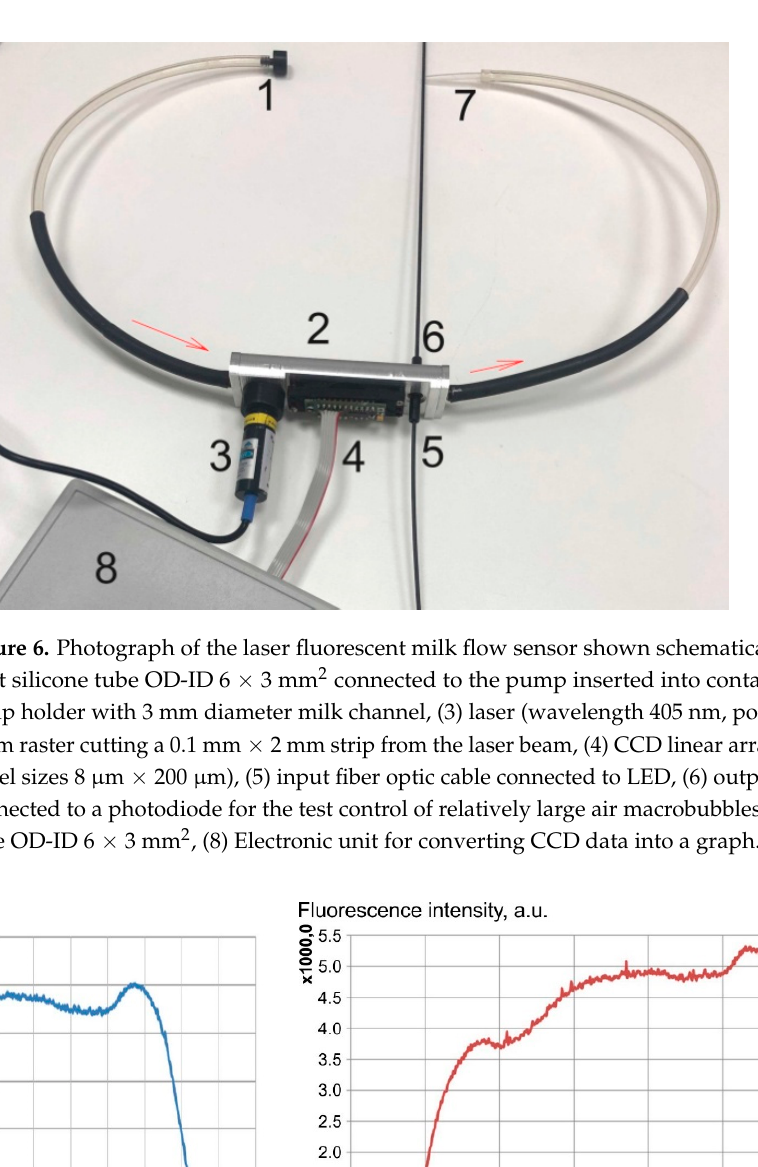
Figure 8. Block diagram of the setup for measuring laser extinction with multichannel fiber-optic bundles: (1) milk container, (2) tap, (3) pump, (4) measuring cell, (5) air bubble generator, (6) fiber bundle with laser diode (850 nm, 200 mW), (7) randomized fiber bundle with a photodetector, (8) randomized fiber bundle with a photodetector of the reference signal, (9) photodetector of differen- tial type, (10) model of milk pipe with a cross-sectional diameter of 3 mm, (11) receiving container for milk. The experimental setup (Figures 8 and 9) provides an imitation of the milking ma- chine operation due to the bubble generator. The milk flow in the milk pipe is not constant, but a succession of air and milk parts of unequal size. The elements 6 and 8 constitute together a fiber optic based optocoupler. Accordingly, the receiver 8 measures the extinc- tion of the intensity of the laser source 6 after passing across the tube in which the milk flows. The optical extinction during the passage of dispersed milk components through